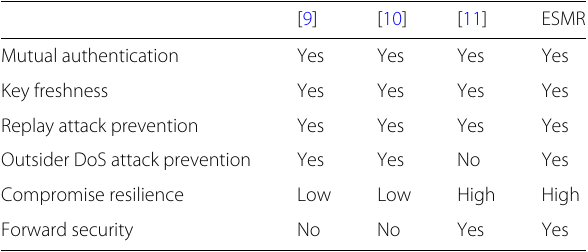
Table 2 Security comparison between ESMR and related schemes